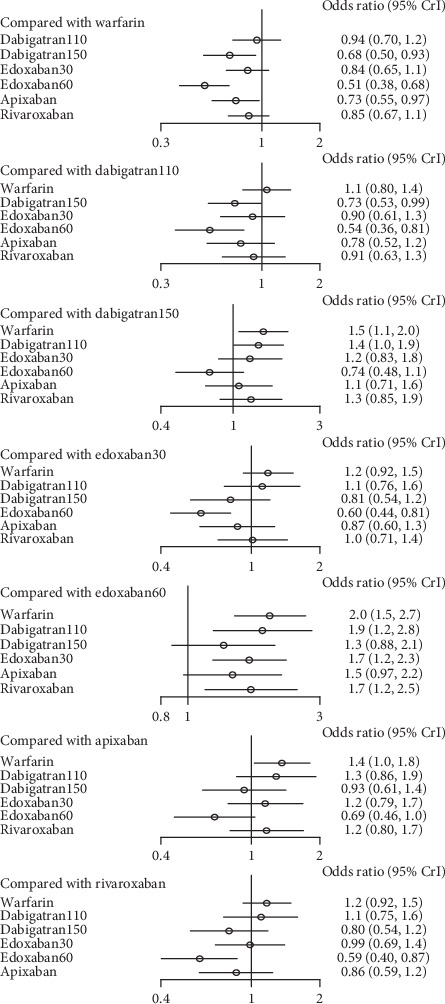
Forest plot for the efficacy of the comparison among different treatments of patients with mild renal function.